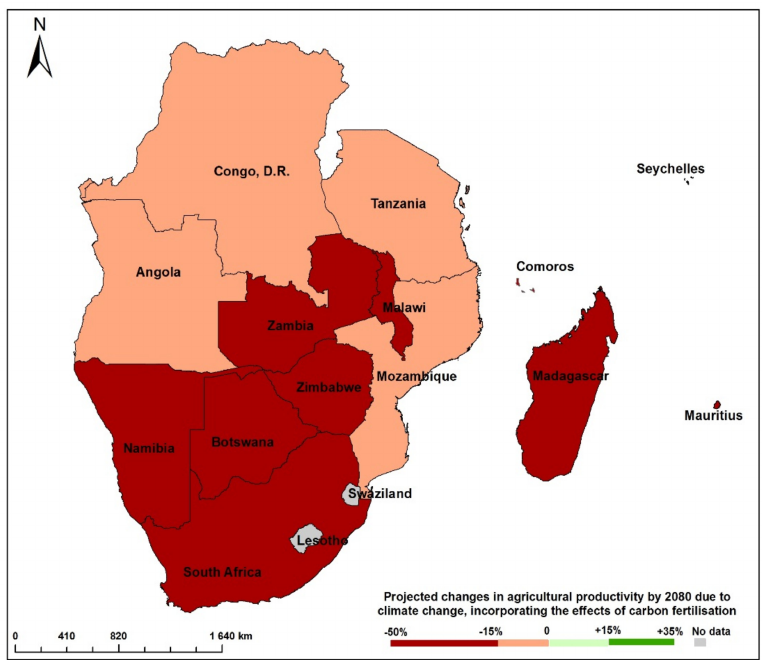
Figure 4. Projected changes in agricultural productivity in 2080 due to climate change. Source: Adapted from Ahlenius and UNEP/GRID-Arendal [26].